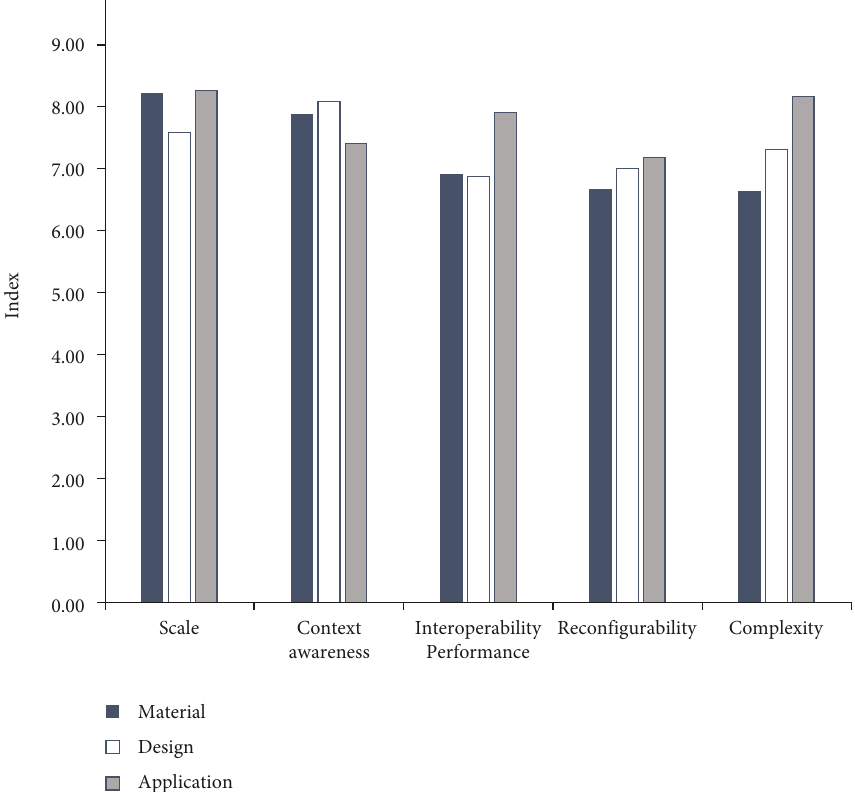
Figure 4: Characteristics of smart manufacturing in smart cities.